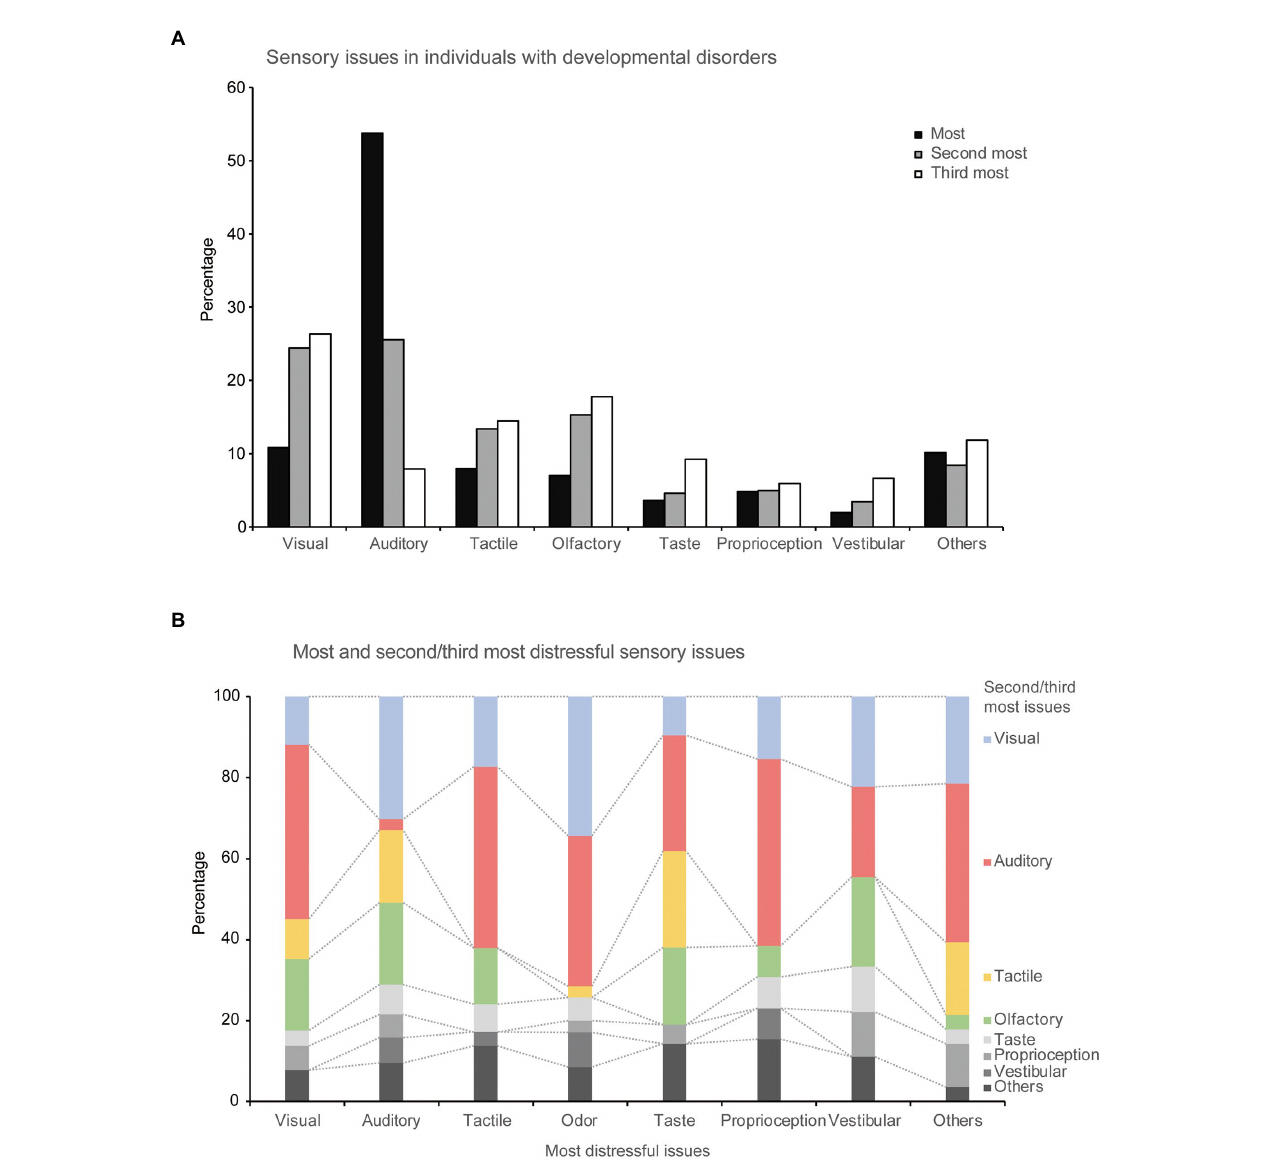
= 0.0034; Supplementary Figure S2B; Supplementary Tables S5B,